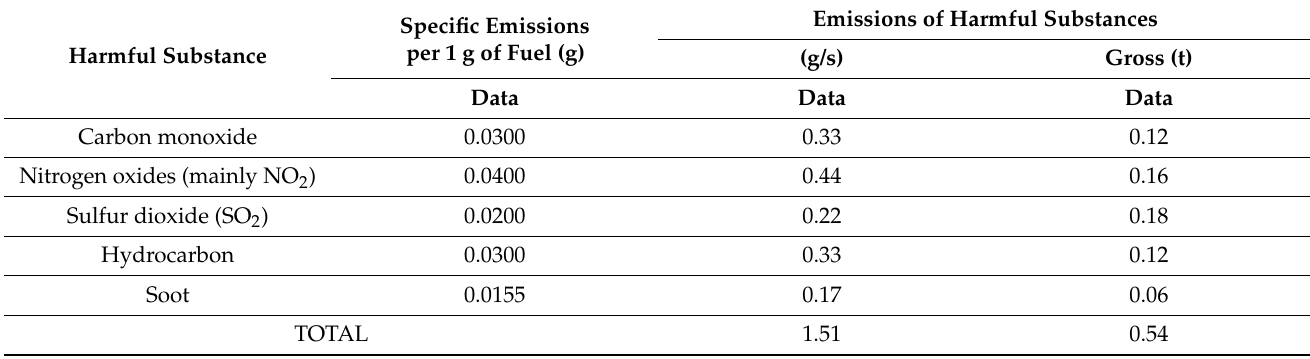
Table 2. Emissions of the equipment during the mixing of the gas.